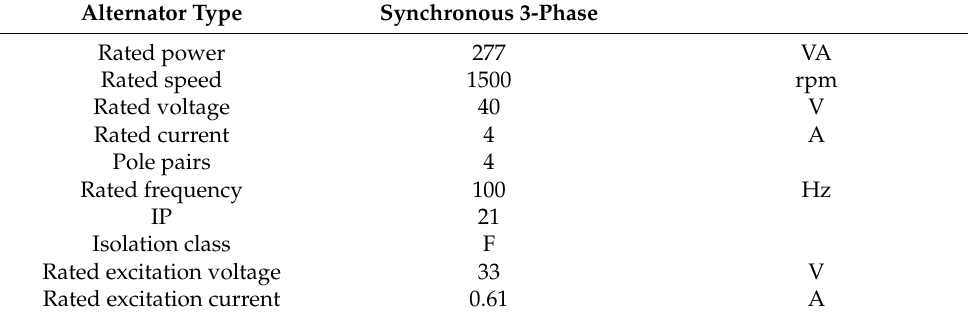
Table 3. Exciter